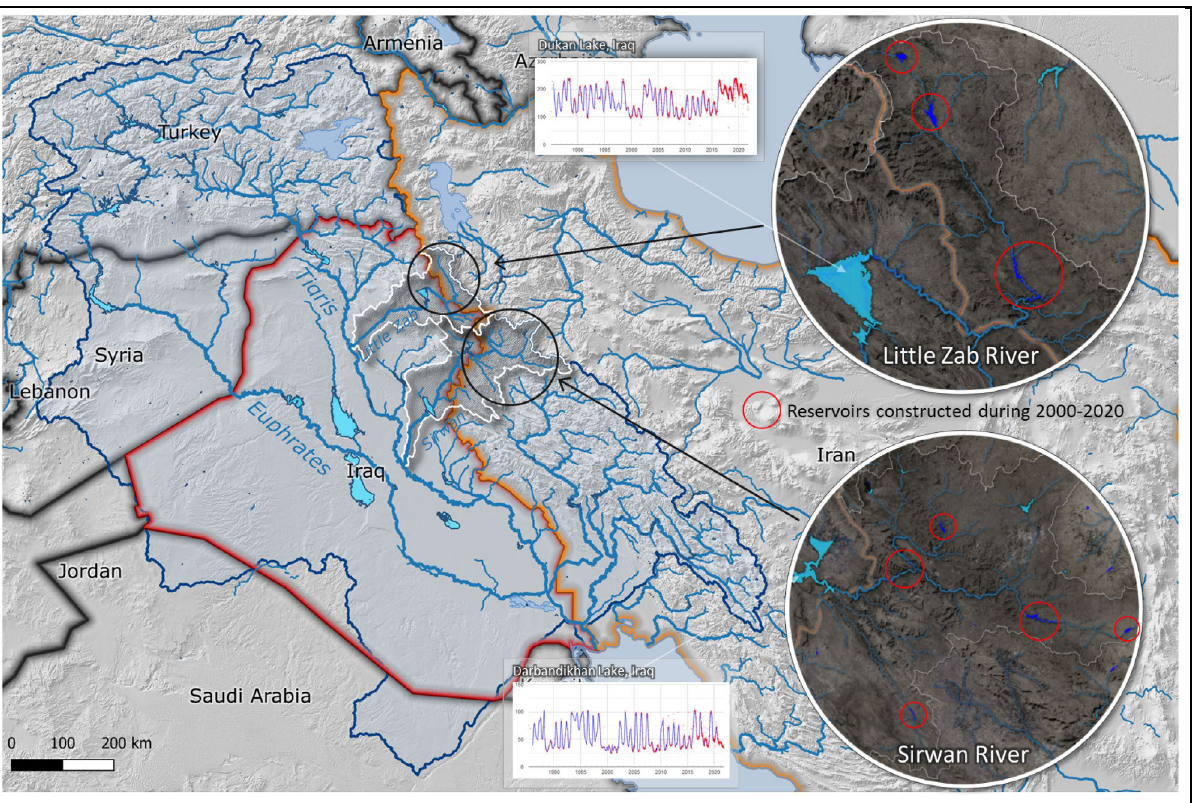
Figure 5. Reservoirs in the transboundary basin of Tigris–Euphrates and small reservoirs constructed during 2000–2020 in Iran in the upstream part of the Sirwan and the Little Zab rivers. The figure is generated using QGIS 3.18 47 and QGIS Google Earth Engine plugin 48